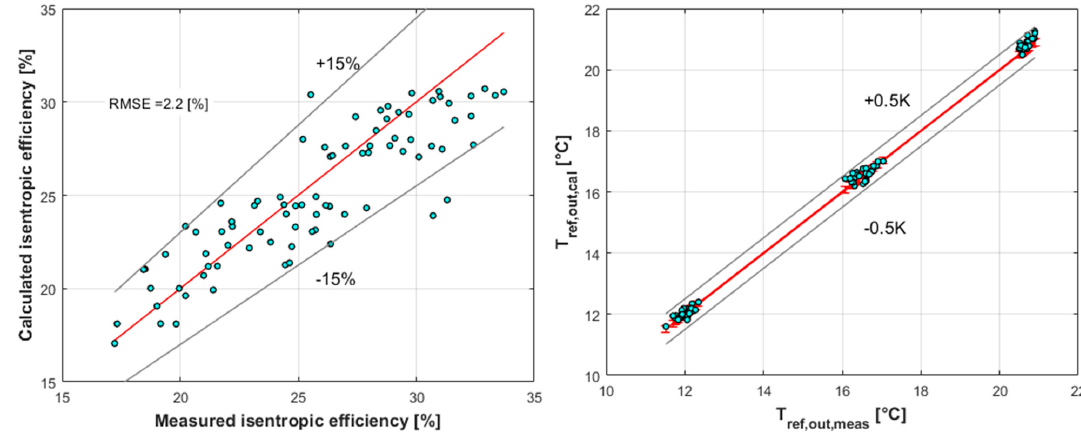
Figure 14. Measured and calculated pump isentropic efficiency ( left ) and discharge temperatures ( right ).